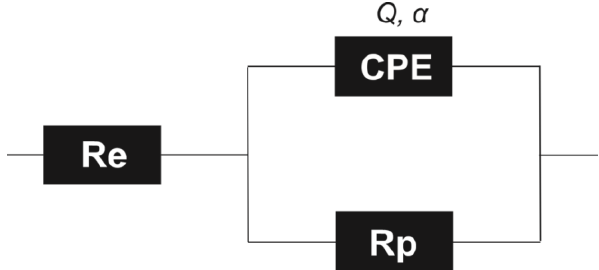
Figure 3. Equivalent electric circuit used to model the EIS diagrams.